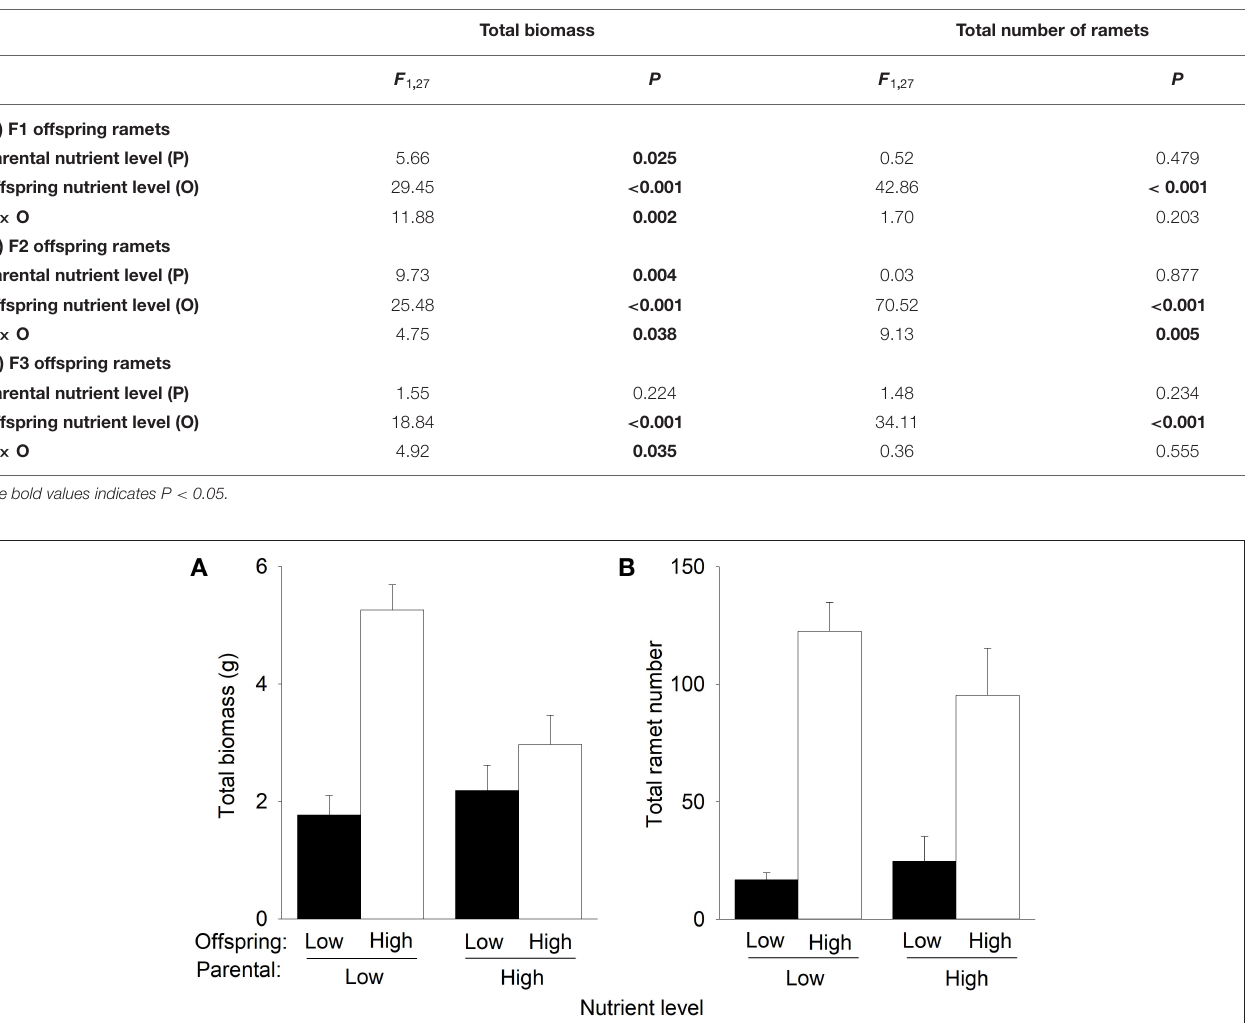
TABLE 1 | ANOVA results for effects of parental nutrient level, offspring nutrient level, and their interaction on total biomass and total number of ramets of Pistia stratiotes produced by the (A) F1, (B) F2, and (C) F3 offspring ramets.